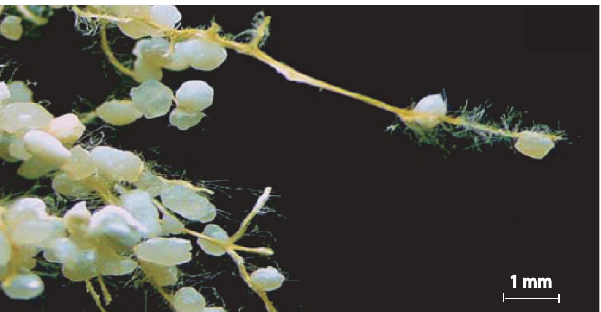
Fig.6. Rootsystemof AvenaSativa showingthedevelopmentofhairyrootswhichmayleadtosediment entrapment. Fig. 6. Root system of Avena Sativa showing the development of hairy roots which may lead to sediment